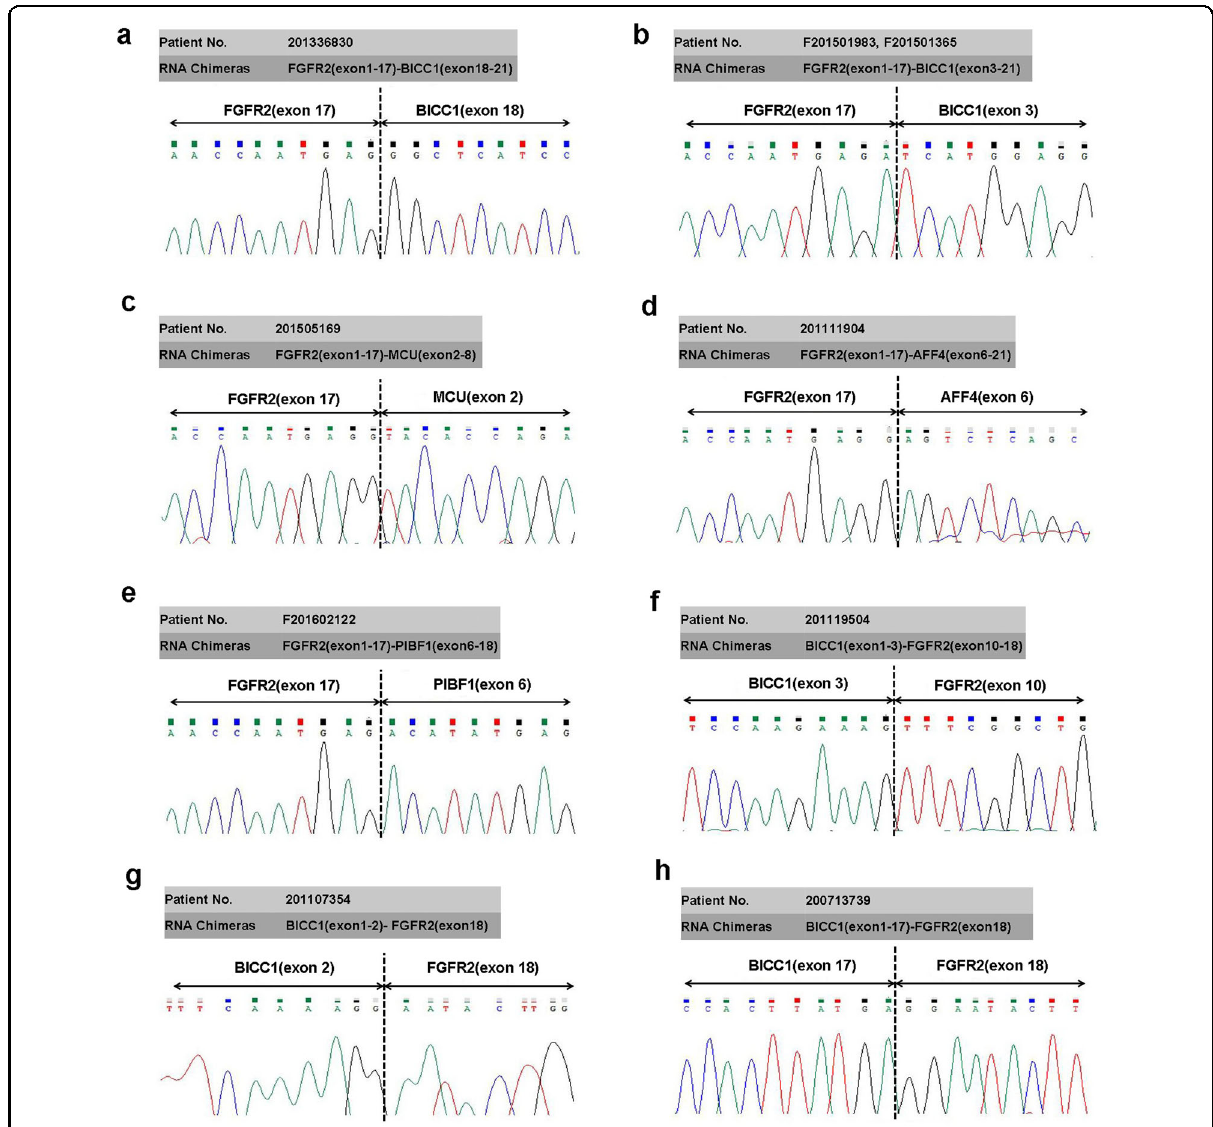
Fig. 2 Sanger sequencing of the RT-PCR product validates in-frame fusion transcripts. Fusion transcripts were detected as FGFR2(exon 1-17)- BICC1(exon 18-21) ( a ), FGFR2(exon 1-17)-BICC1(exon 3-21) ( b ), FGFR2(exon 1-17)-MCU(exon 2-8) ( c ), FGFR2(exon 1-17)-AFF4(exon 6-21) ( d ), FGFR2(exon